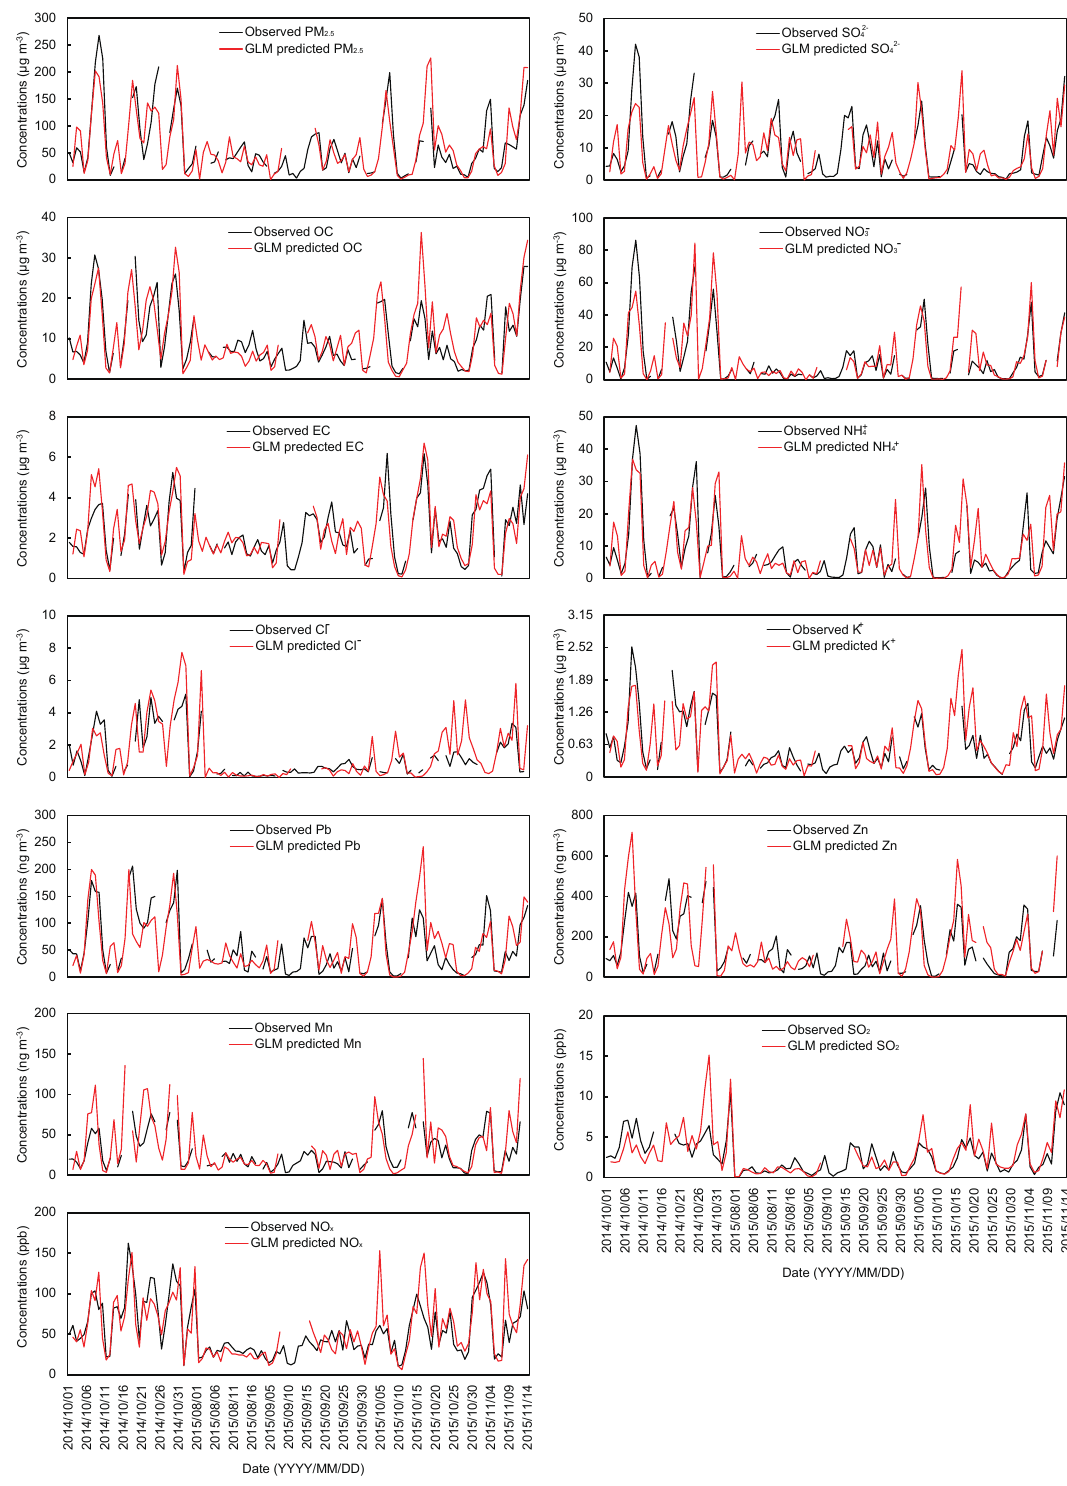
Figure 8. Time series of the observed (in black line) and GLM-predicted pollutant concentrations (in red line).